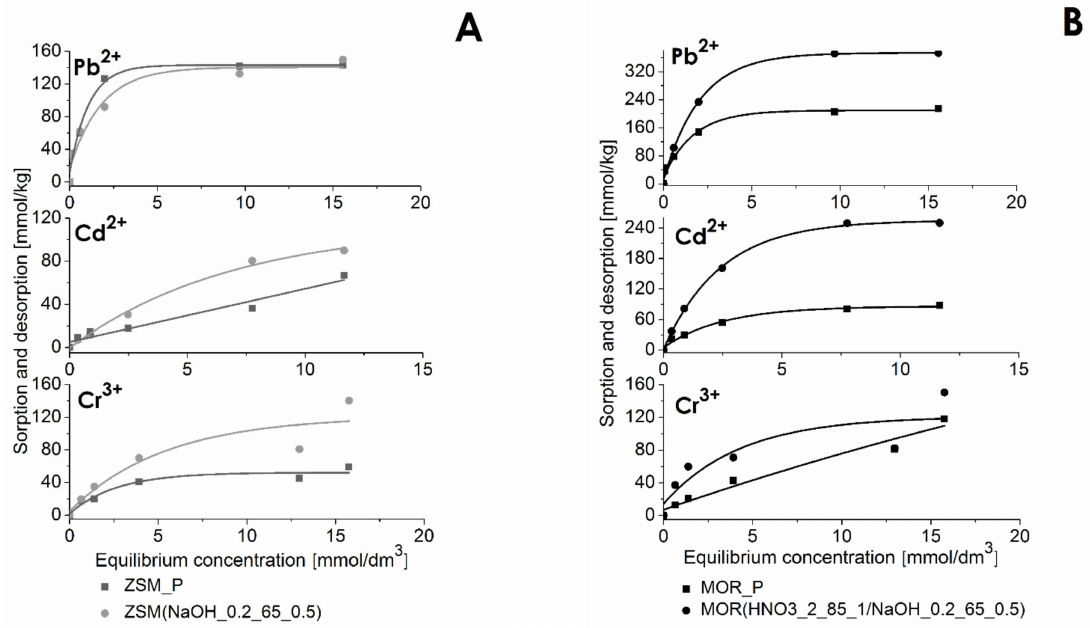
Figure 6. Results of sorption of heavy metal cations on ZSM_P and MOR_P and their modified analogs: ( A ) ZSM(NaOH_0.2_65_0.5) and ( B ) MOR(HNO 3 _2_85_1 /